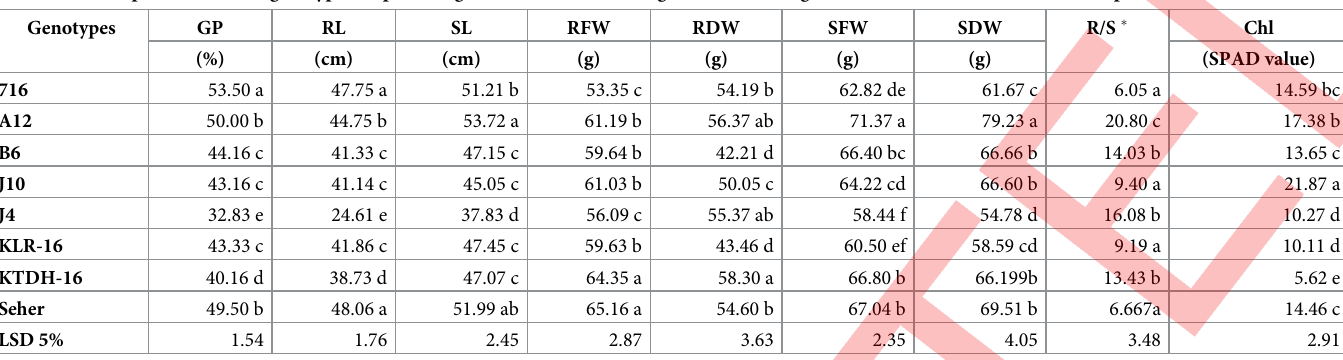
Here, GP = seed germination percentage, RL = root length, SL = shoot length, RFW = root fresh weight, RDW = root dry weight, SFW = shoot fresh weight,